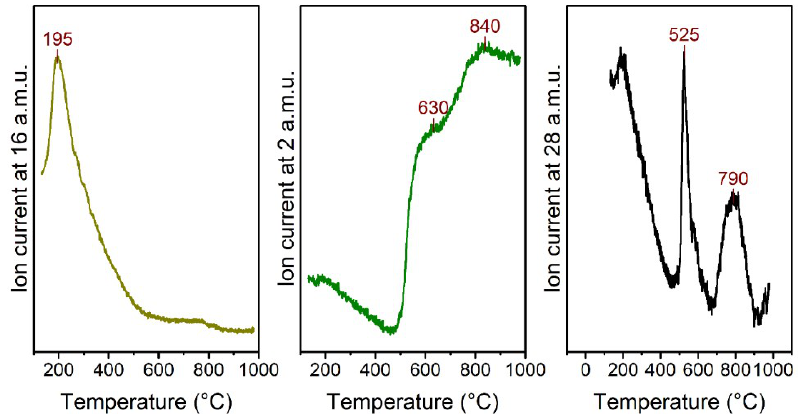
Figure 7. NH 3 TPD results of a Ni 2 Mo 3 N sample heat-treated in a H 2 /N 2 atmosphere at 650 °C.